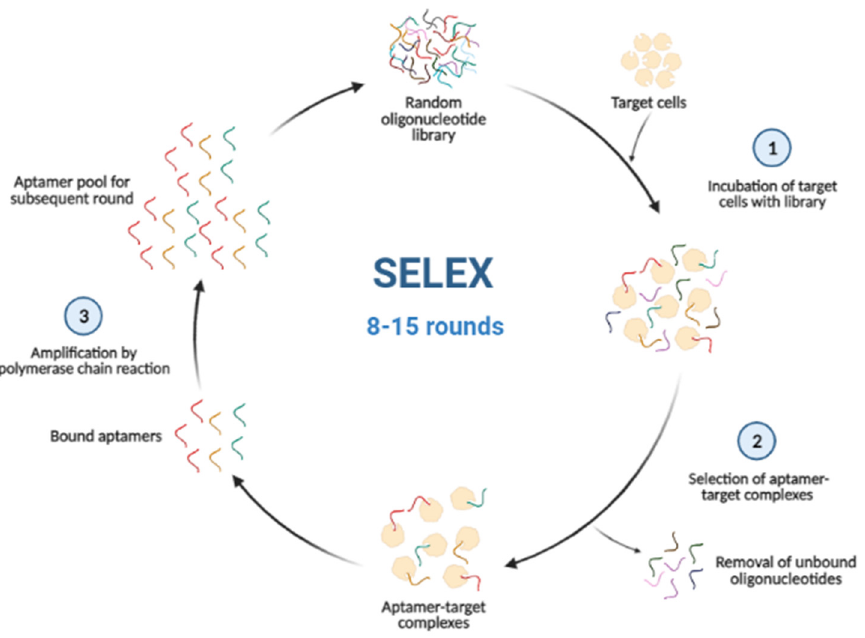
Figure 1. A general scheme of SELEX protocol. (Created in BioRender.com, accessed on 9 September 2022).